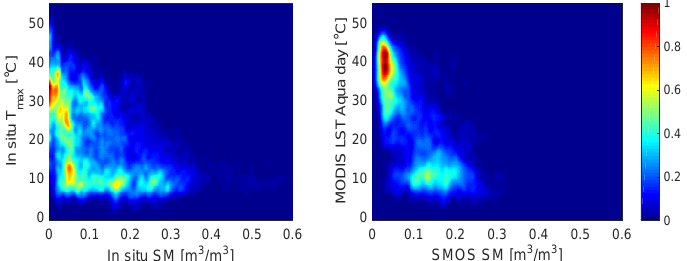
Figure 7. Normalized occurrence frequency density diagrams of in situ SM at the SMOS morning passes and T max ( left ), and SMOS SM at the morning passes and MODIS LST Aqua day ( right ). Similar behavior is obtained at the afternoon passes and/or using Terra